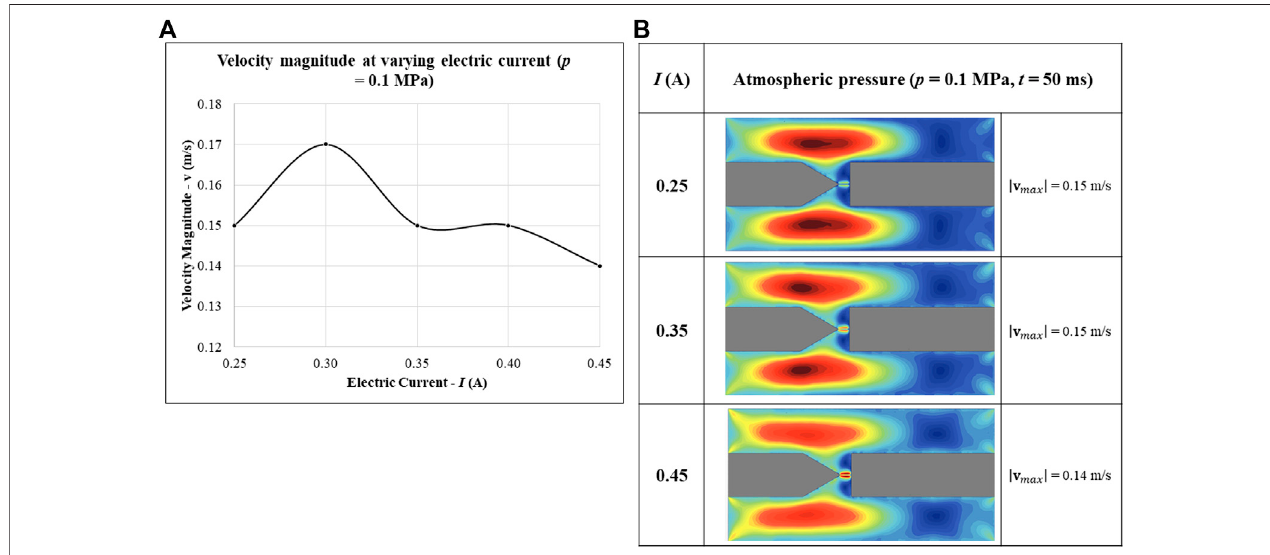
FIGURE 15 | (A) Velocity magnitude in the x axis direction at the center of the inter-electrode gap for varying current ( t (cid:2) 50 ms, p (cid:2) 0.1 MPa), (B) Images of the velocity magnitude at varying current; ( t (cid:2) 50 ms, p (cid:2) 0.1 MPa).